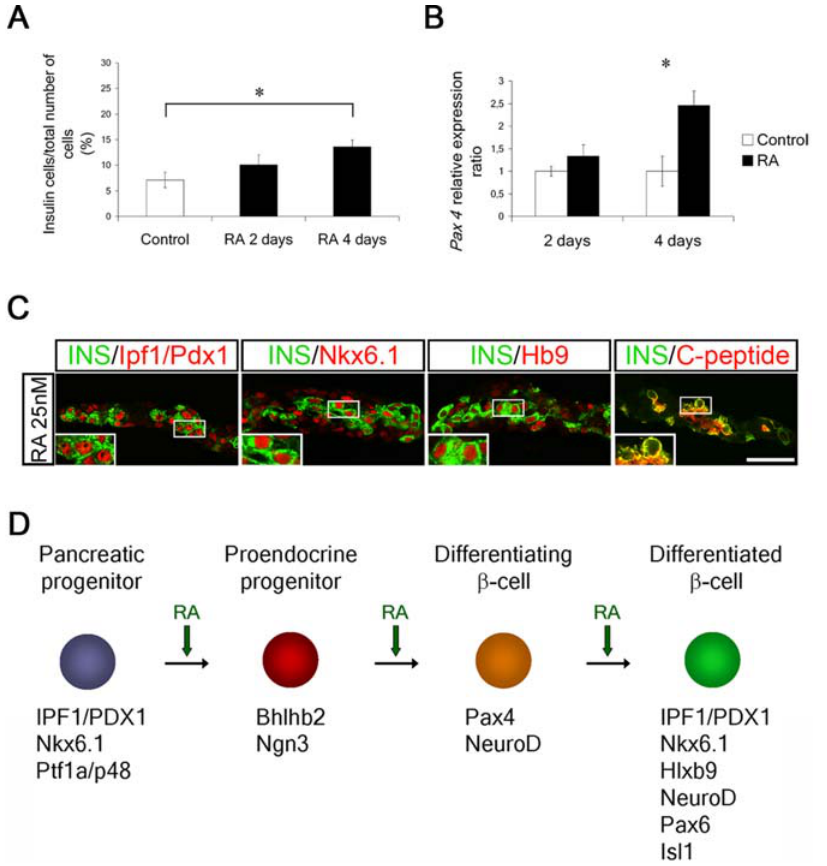
Figure 4. Temporal changes in the expression of Bhlh and homeobox genes in response to RA. ( A ) Quantification of Ins + cells in control pancreatic explants (n= 6) and pancreatic explants exposed to 25 nM RA for the first 2 (n=3) or 4 days (n=4) of the 6 day in vitro culture period displayed as % positive cells/total number of cells. Data show mean 6 S.E.M, *p , 0.05 **p , 0.01. ( B ) qRT-PCR using Pax4 specific primers on cDNA from control and RA treated e10.5 pancreatic explants cultured for two (n=13) or four days (n=9). Data represent the mean value 6 S.E.M. *p , 0.05, **p , 0.01. ( C ) 6d RA treated explants double-stained for insulin (green) and Ipf1/Pdx1, Nkx6.1, Hb9 or C-peptide (all red). ( D ) Schematic model summarizing the multiple proposed roles of RA during pancreatic development. Our data provides evidence that RA sequentially specifies: i) proendocrine cells; ii) committed pre- b -cells; and finally iii) differentiated b -cells. Scale bar=30 m M in ( C ) (7,5 m M for the enlarged inserts).